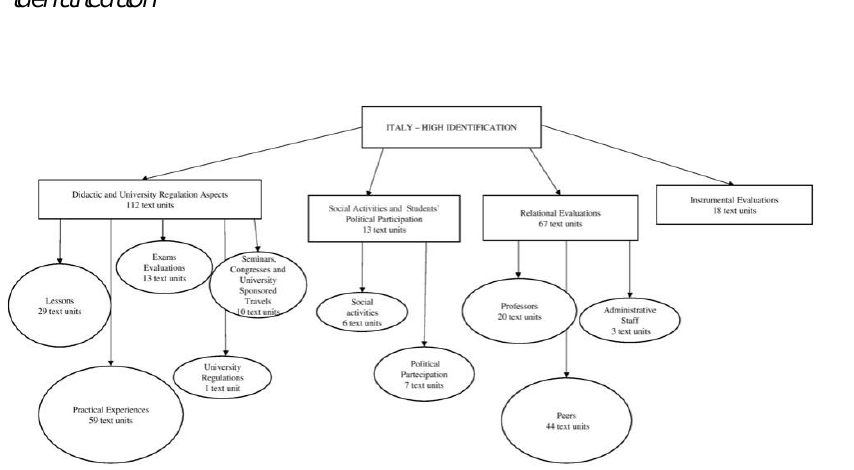
Concept map concerning Italian students in the condition of high identification